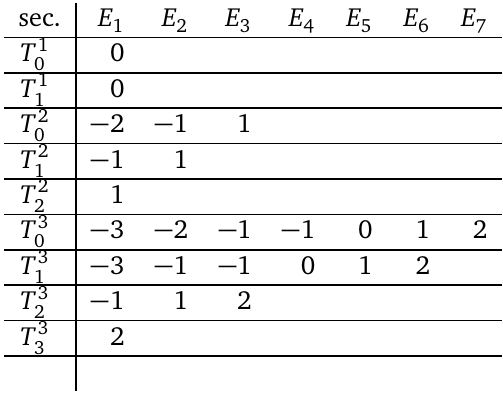
of triplet runs up to i